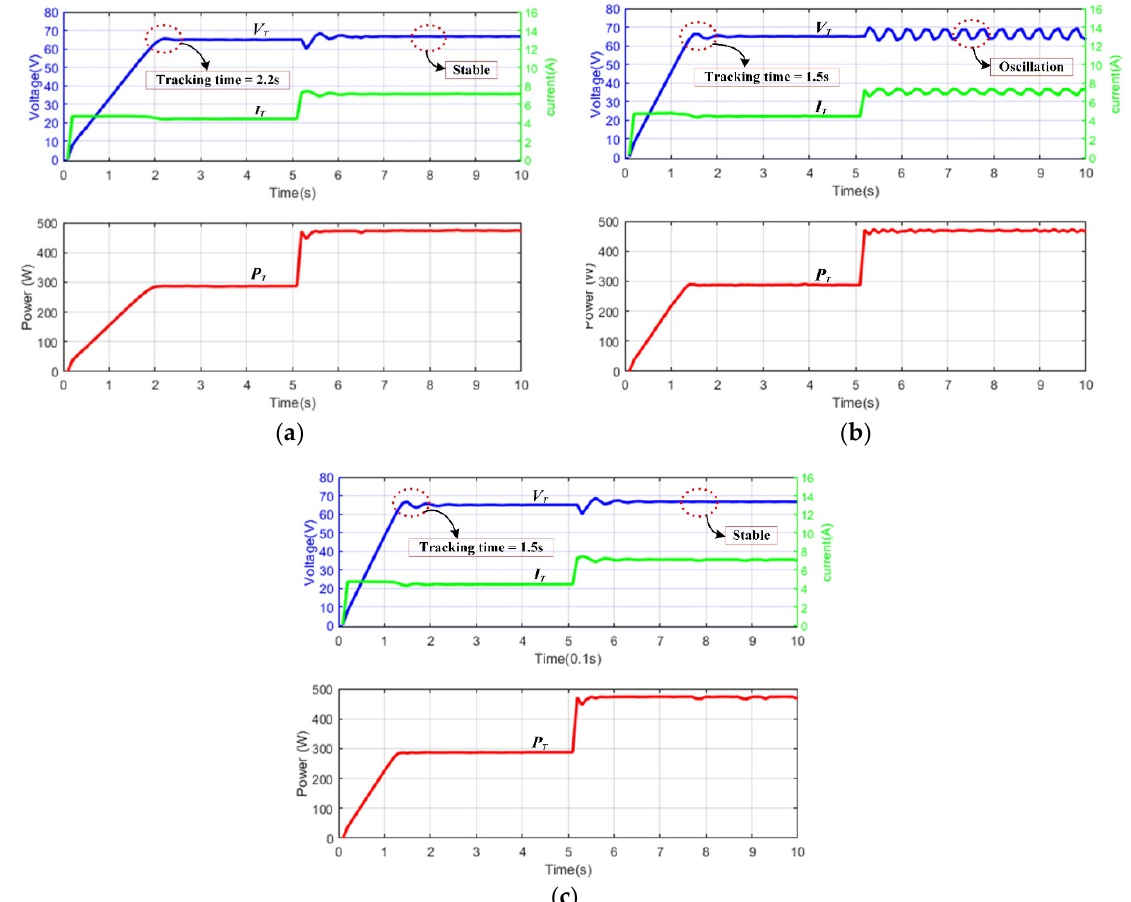
Figure 9. Experimental results of different M values ( a ) M = 0.65, ( b ) M = 1.08, ( c ) M = 1.08/0.65.